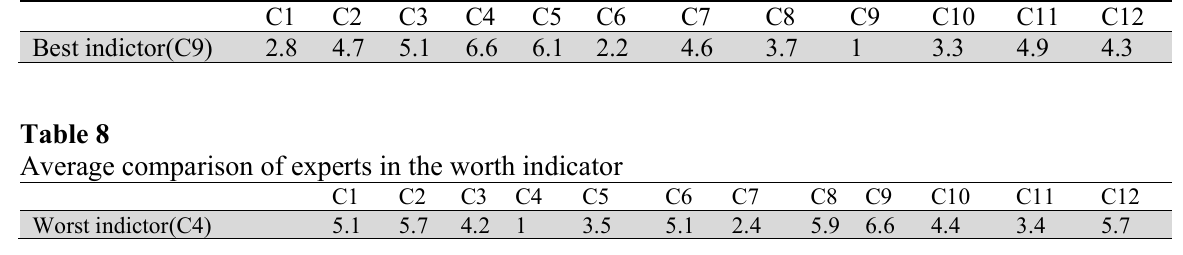
Average comparison of experts in the best indicator